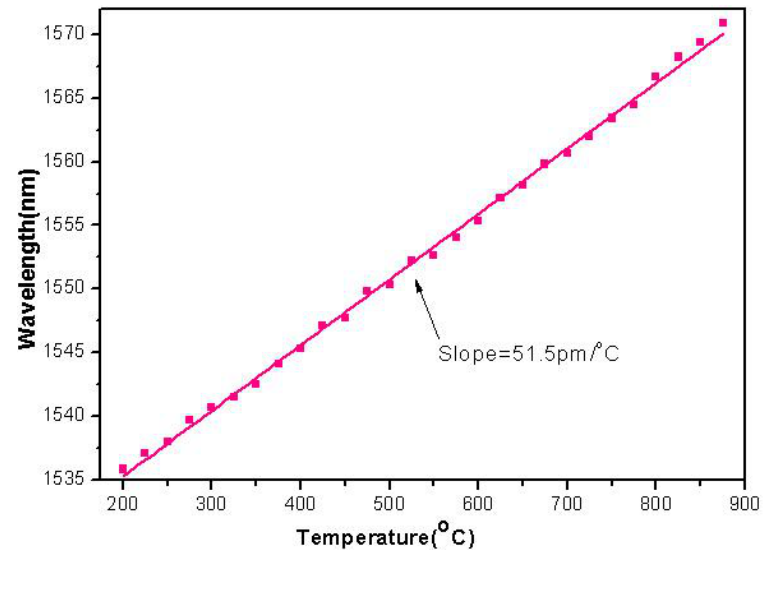
Figure 6. The temperature sensing property of the